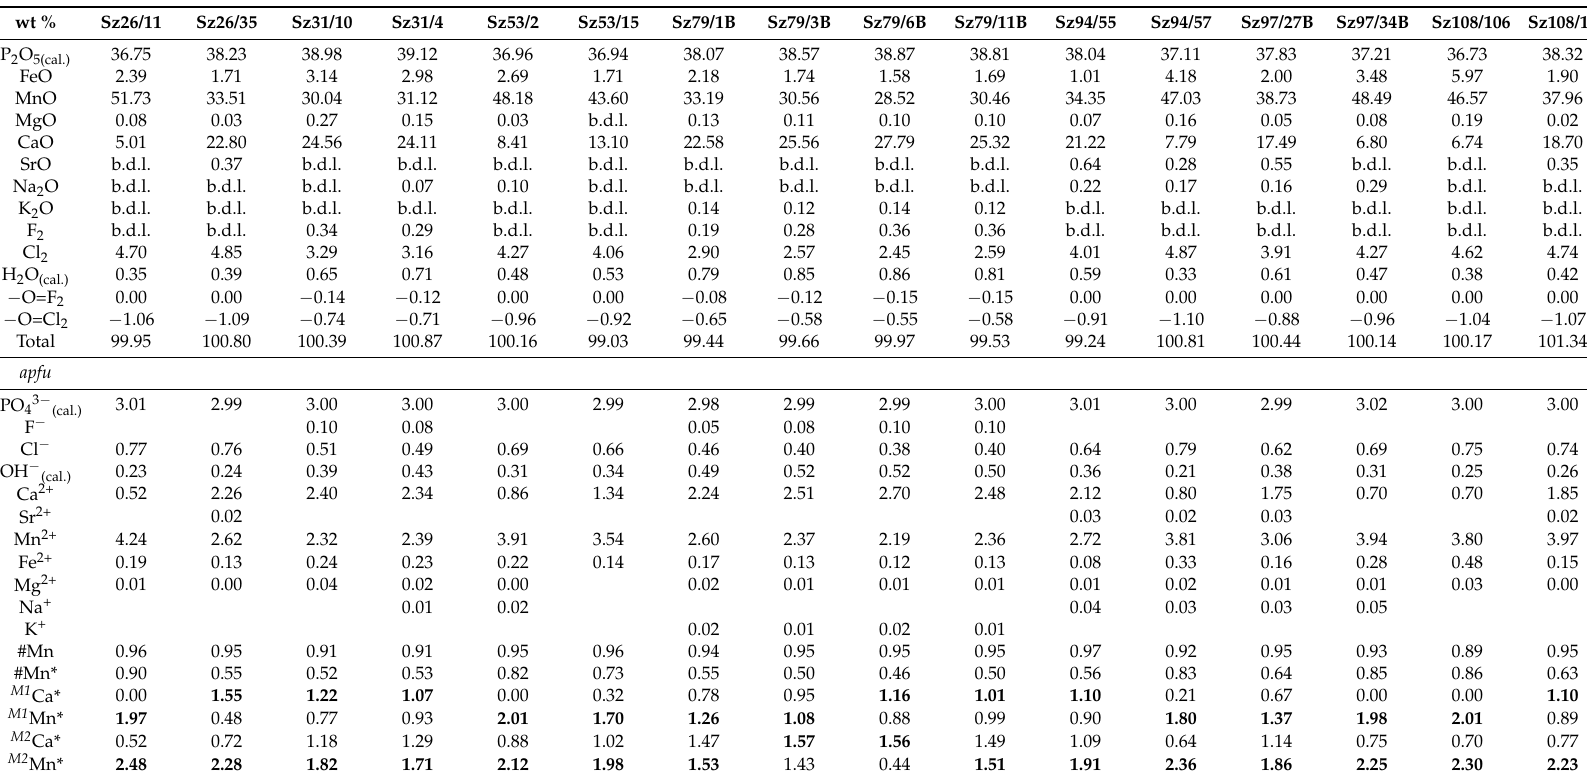
Table 2. Representative chemical compositions and proposed cation distributions (dominant components are bold) between the M 1 and M 2 sites in the Type 1 apatites from the Szklary pegmatite. Sz26/35 = sample/analysis, b.d.l. = below detection limit, Ca* = Ca + Sr + Na + K, Mn* = Mn + Fe + Mg, #Mn = Mn/(Mn + Fe) and #Mn* = Mn*/(Mn* + Ca*). Further explanations in the text. wt % P 2 O